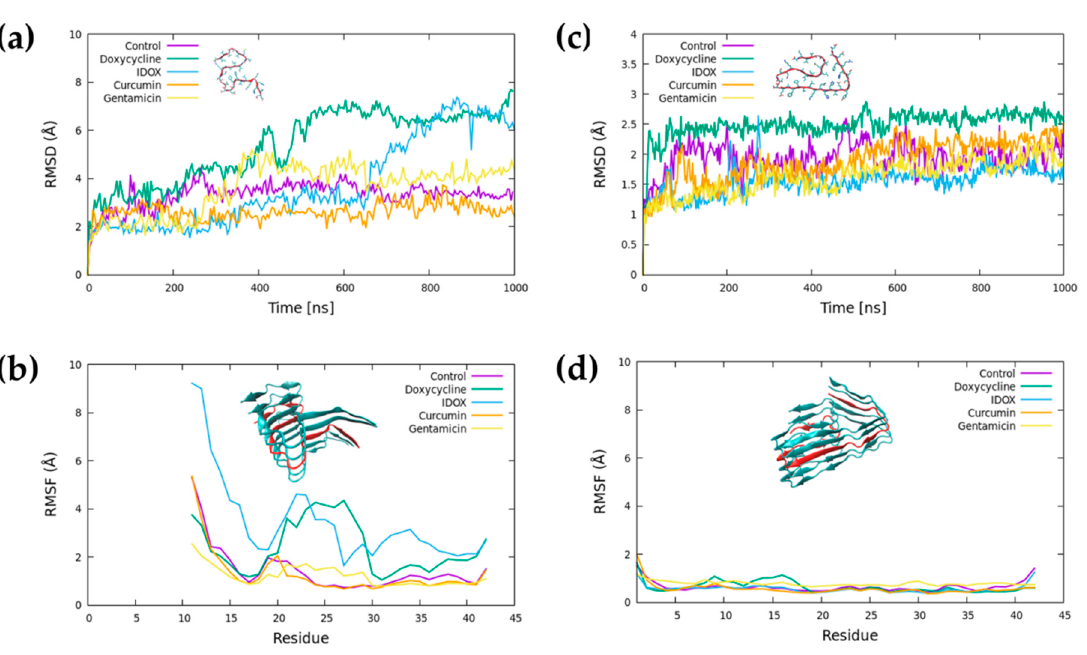
Figure 4. Average contact time between anti-amyloidogenic molecules and the two different polymorphs of A β 42 fibrils, 2MXU ( a ) and 5OQV ( b ) during the MD simulation. The contact time is the amount of time (as a percentage) during which the molecule is in contact with the fibril. The 5 ns window is meant to exclude sporadic contacts due to the high simulated concentration. 2.2. Doxycycline Binding